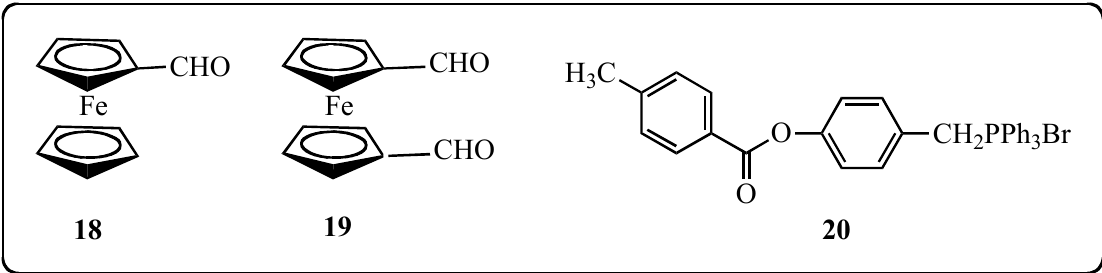
Figure 4. Starting reagents for the preparation of ferrocenyl-stilbene analogs 18 – 20